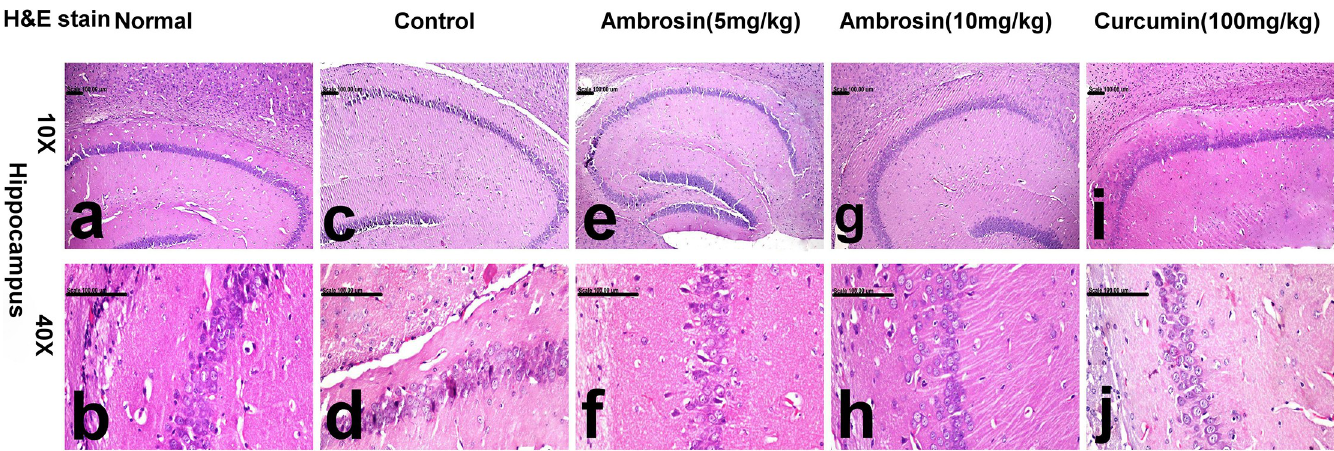
PLOS ONE | https://doi.org/10.1371/journal.pone.0219378 July 5,